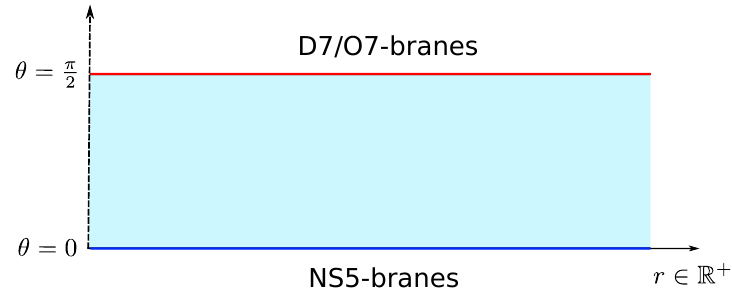
Figure 2 . The in(cid:12)nite strip for the non-Abelian T-dual background. NS5-branes are smeared along the lower boundary at (cid:18) = 0 and D7/O7 branes are smeared along the upper boundary at (cid:18) = (cid:25)= 2. The strip topology follows from the unboundness of the r direction, r 2 R +